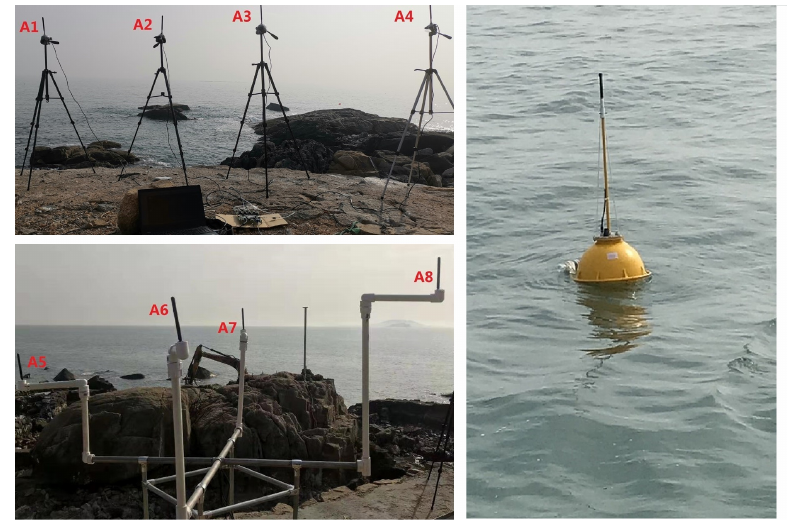
Figure 12. The sink node and the sensor node in the ocean